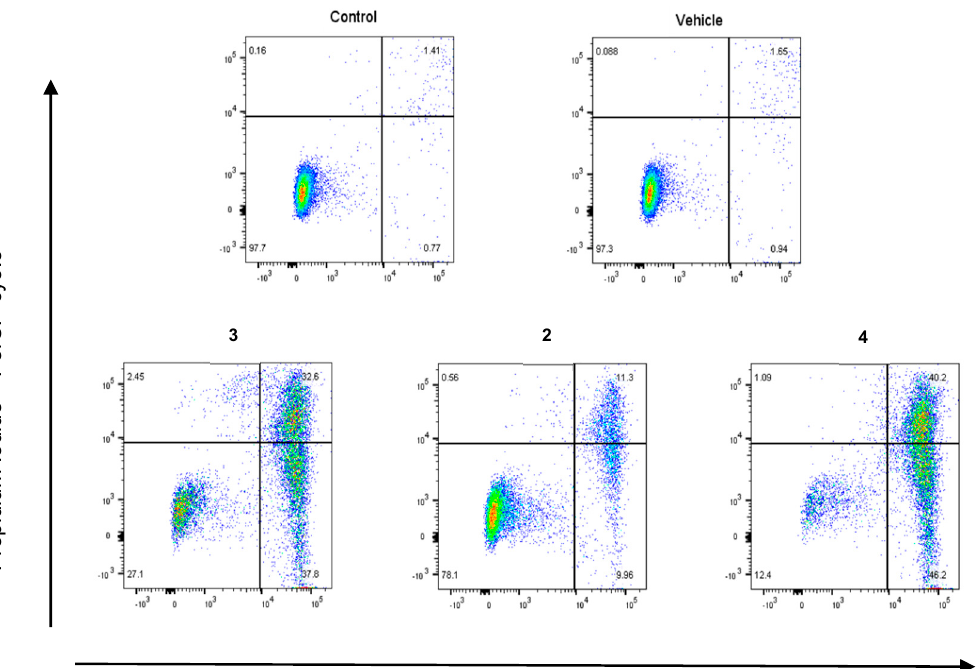
Figure 5. Annexin V-FITC vs. PI flow cytometry analysis of HL-60 cancer cells treated with compounds 3 (5 µ M), 2 (5 µ M) and 4 (4 µ M) for 48 h. These figures are representative of three independent experiments. The viable cells, early apoptotic, necrotic and late apoptotic cells are represented by the lower left, lower right, upper left and upper right quadrants,